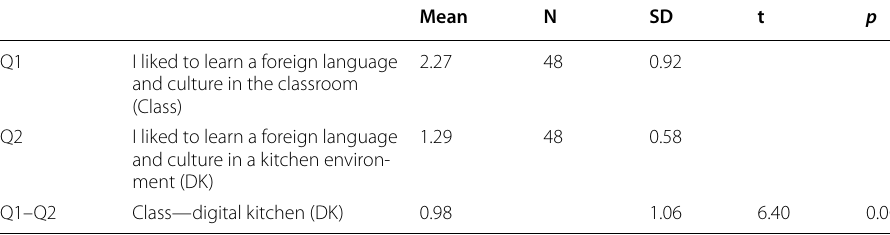
Table 2 Preferences toward two learning